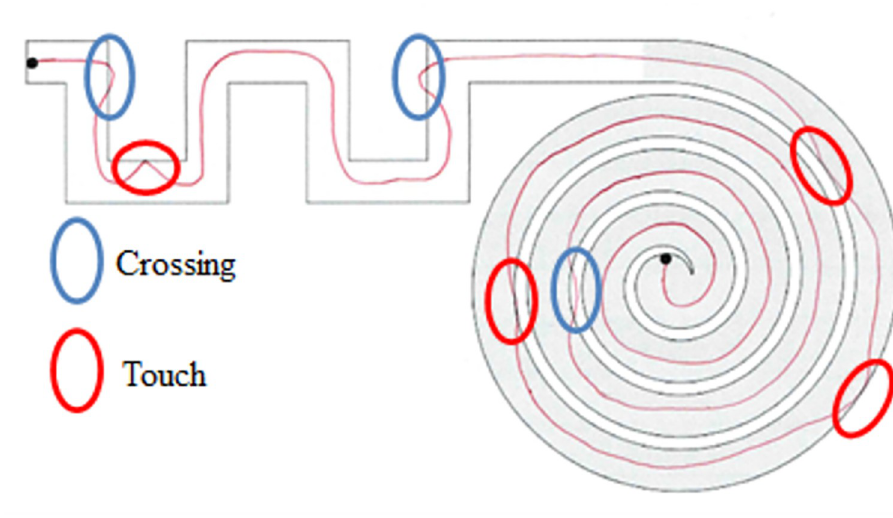
assess whether there were points in common between the two images and a new image was